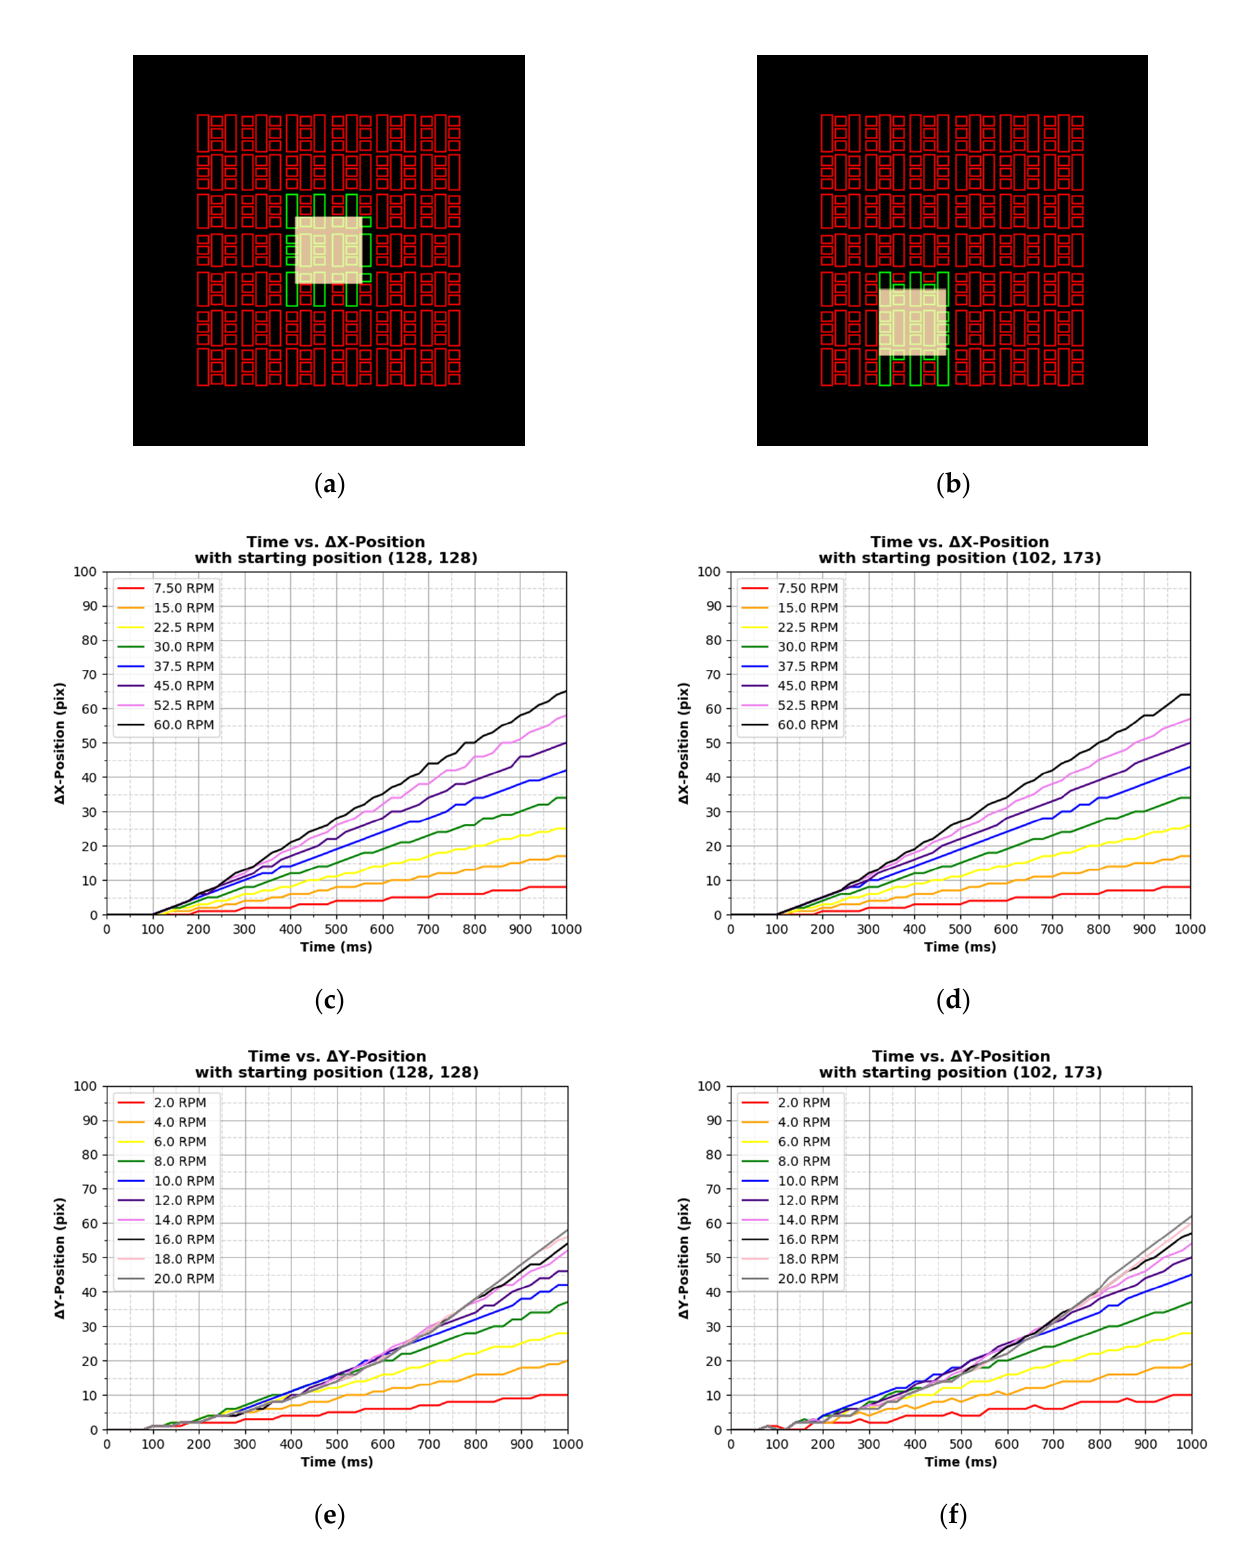
Figure 11. Two different starting positions viz. ( a ) (128, 128) and ( b ) (102, 173) were evaluated. Their step responses in terms of X-axis are as shown in ( c , d ), respectively. Whereas, in term of Y-axis, their step responses are respectively shown in ( e , f ).